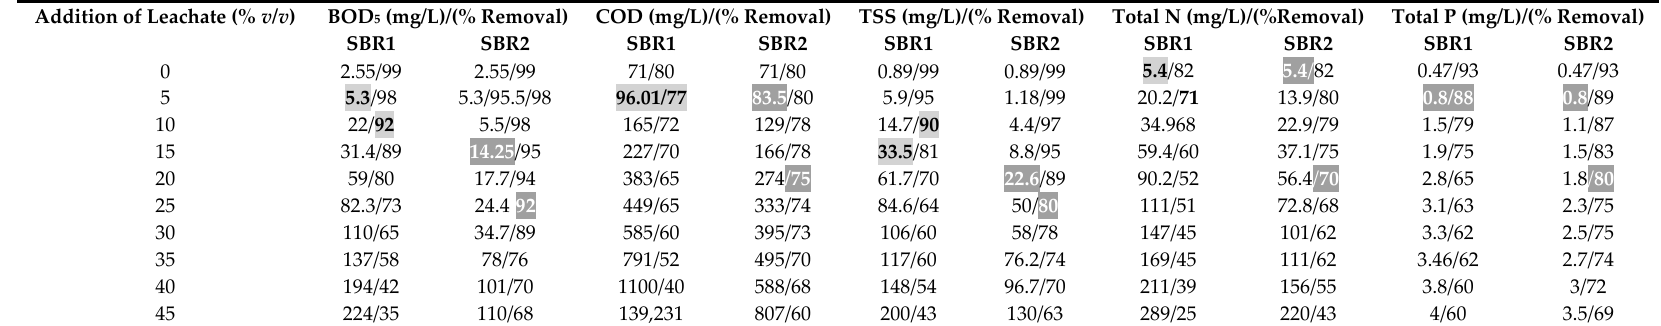
Table A4. Characteristic of effluents (the highlighted text indicates the limit value given by Polish legislation; the values marked light grey and dark grey (with white font)) are for the control reactor and reactors fed with mixtures with pretreated leachate,